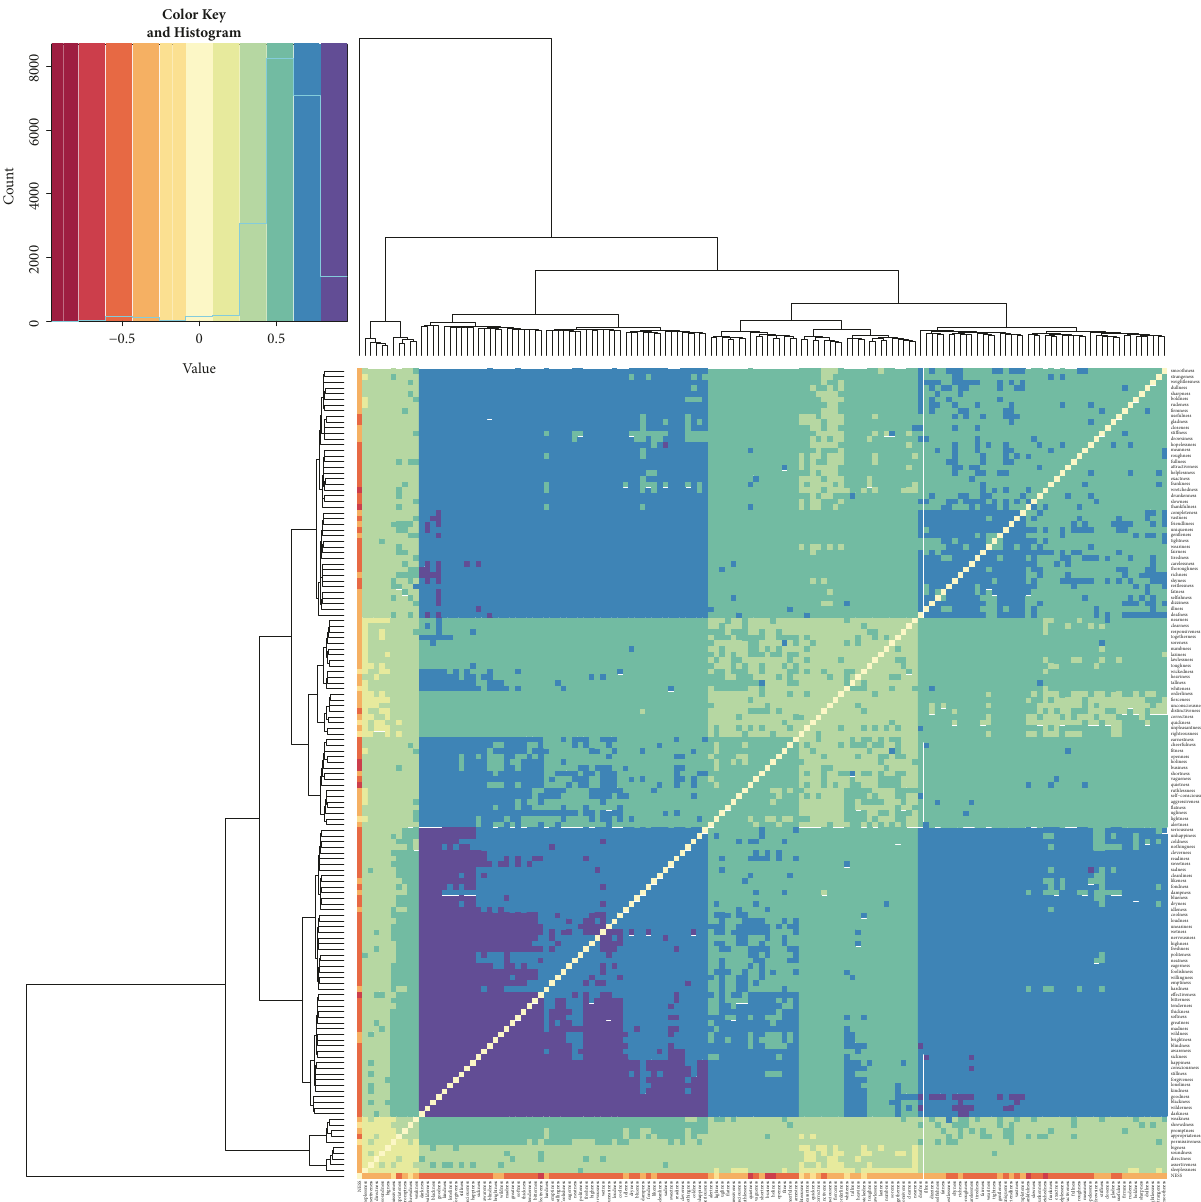
Figure 3: Heatmap for the correlation matrix of lexomes for content words with ness, as well as the derivational lexome of ness itself. This lexome is found at the very left edge of the dendrograms, and is negatively correlated with almost all content lexomes (Individual words will become legible by zooming in on the figure at maximal